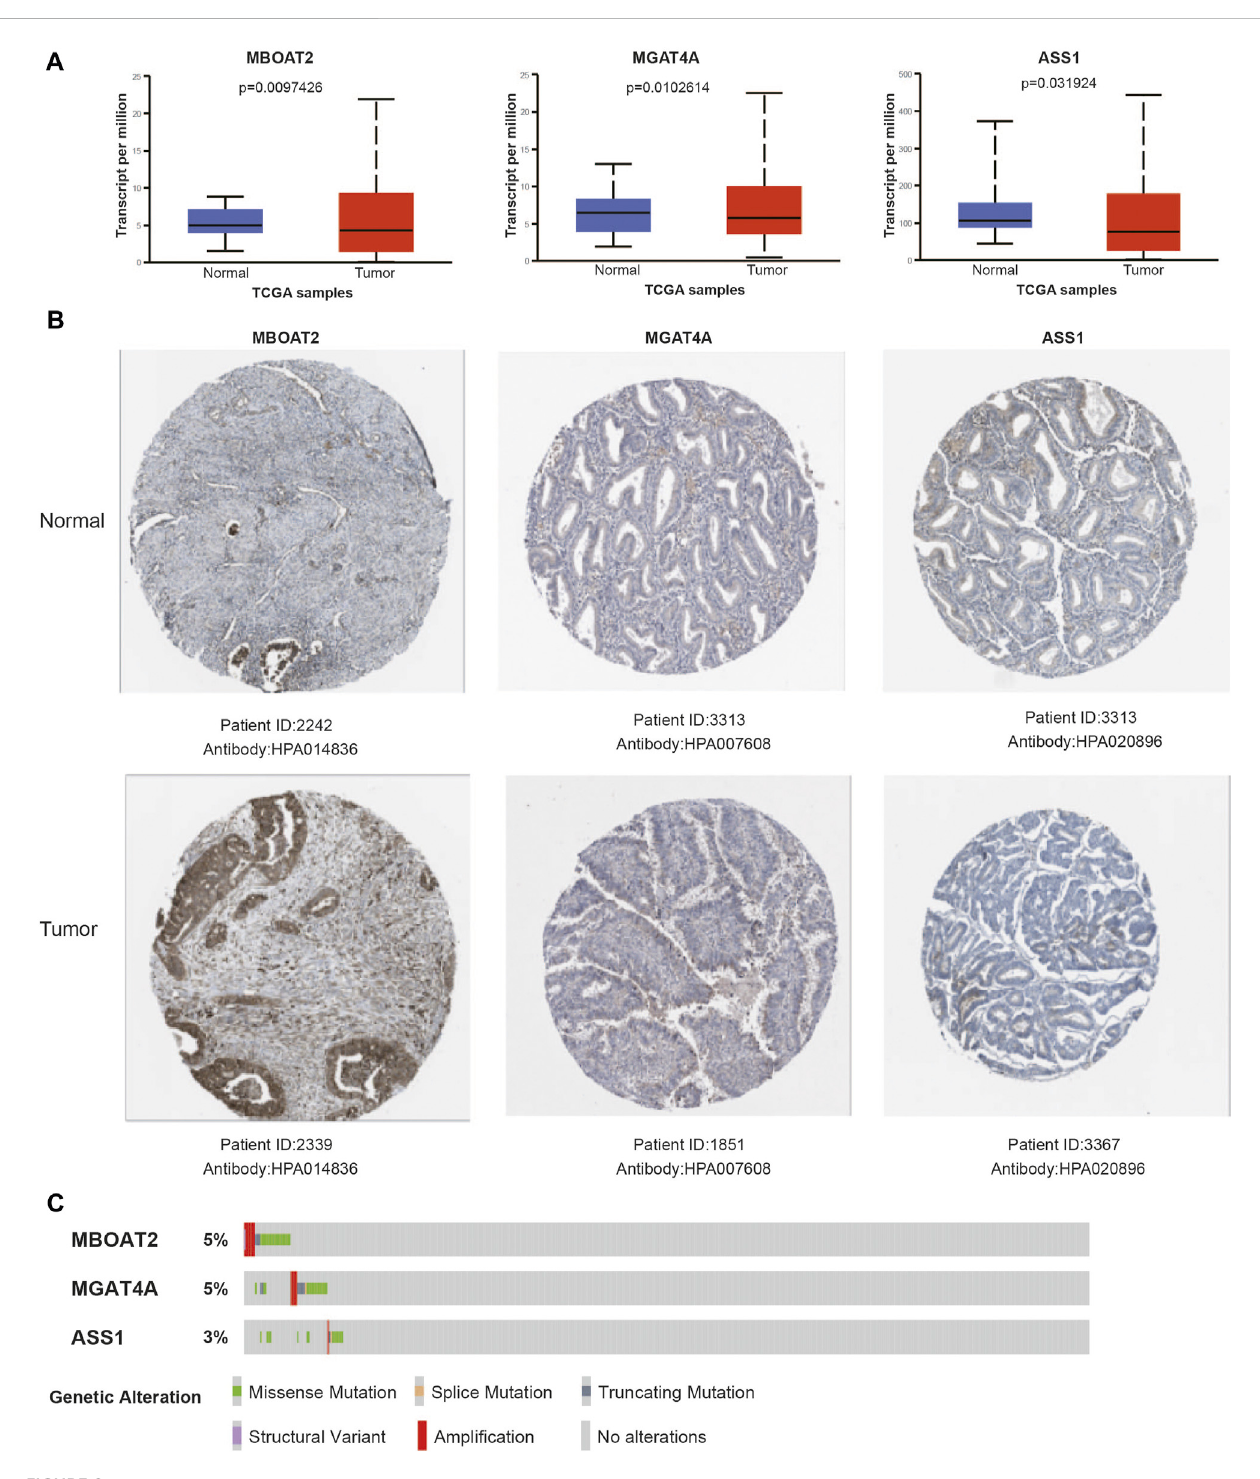
FIGURE 9 Veri fi cation of gene mRNA and protein expression in the risk model. (A) The mRNA expression levels of signature genes in UCEC tumor and normal samples. (B) Representativeproteinexpressionlevelsofeachgeneintumorandnormaltissues. (C) GeneticalterationoncoplotofthethreegenesintheUCEC risk